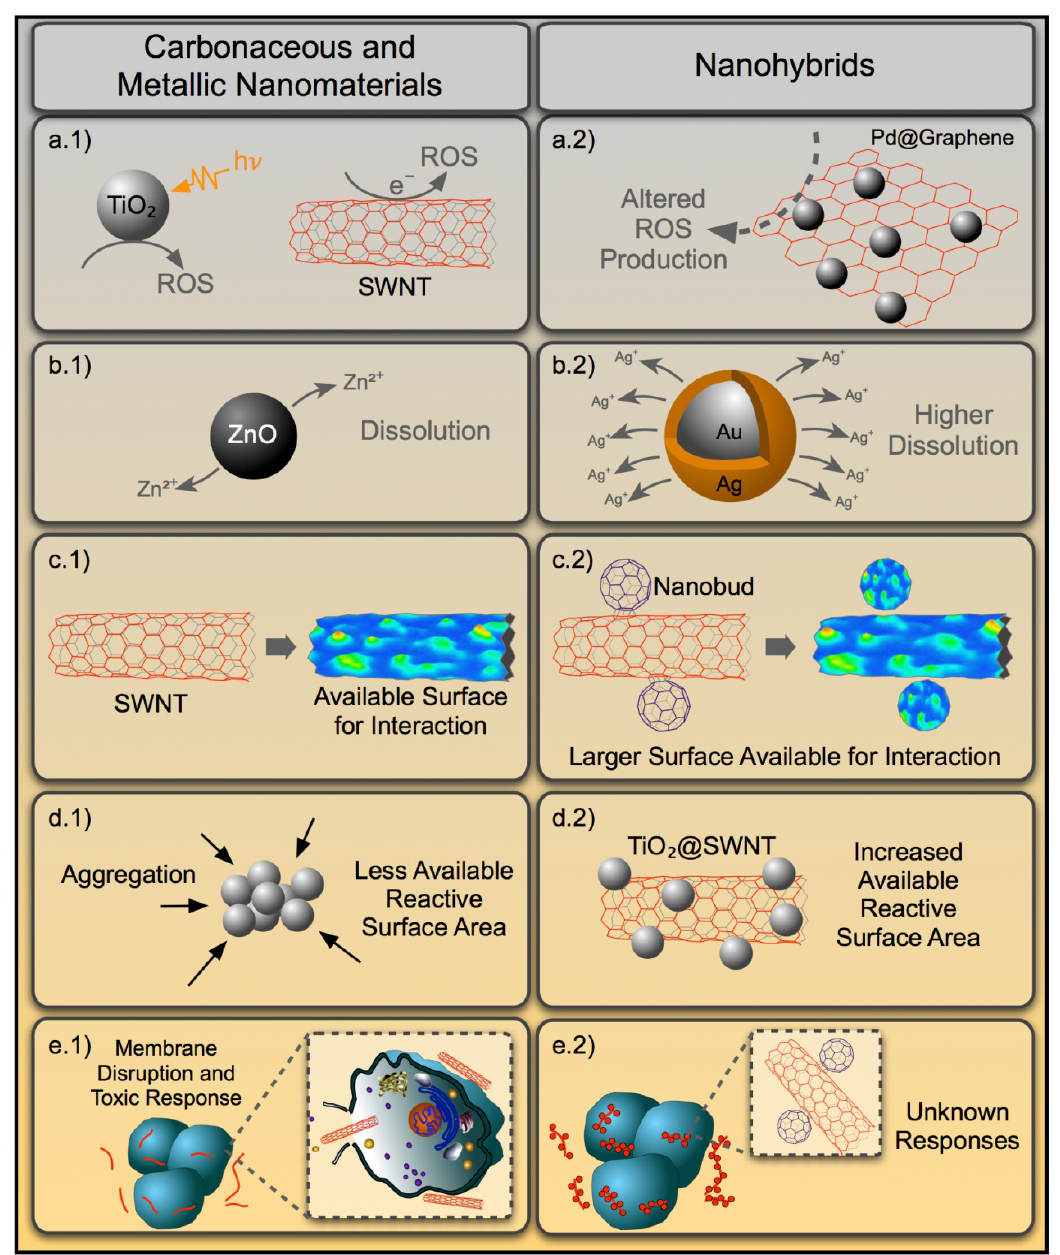
Figure 2. Diagram showing the relevant properties of carbonaceous and metal NMs that are associated with toxicity ( right panels , a.1 – e.1 ). How these properties might be altered for nanohybrid materials is displayed in the corresponding left panels ( a.2 – e.2